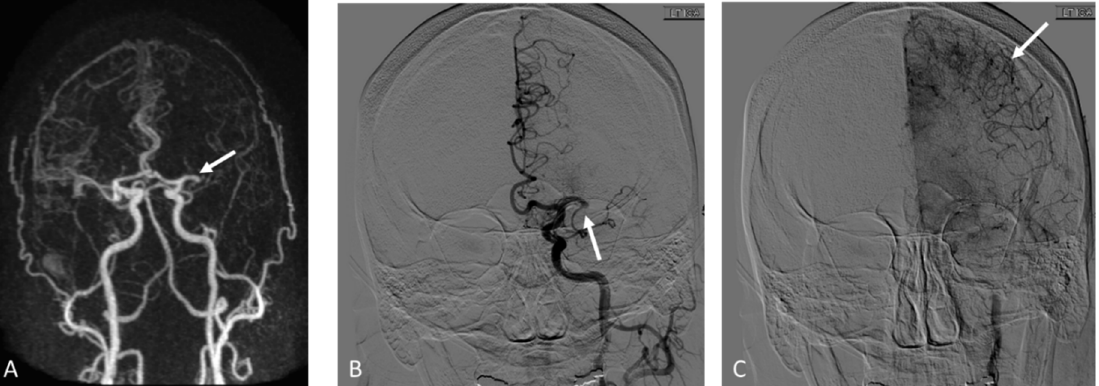
Figure 3. Adult patient who presented with right sided weakness and aphasia, NIHSS: 15. Coronal maximum intensity projection from contrast-enhanced MRA shows left M1 occlusion (arrow in A ) and fewer than 50% collaterals along the left MCA territory in comparison to the right side. Early arterial phase from the follow up digital subtraction angiography confirms M1 occlusion (arrow in B ) while later delayed phase imaging demonstrates robust collaterals (arrows in C ).